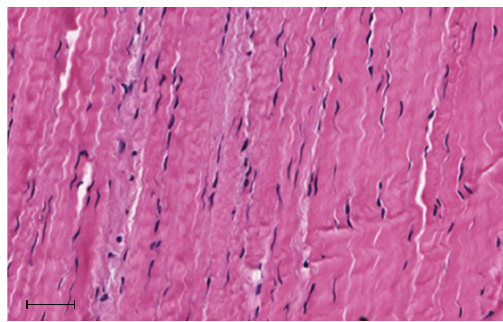
Figure 1: Normal Tendon. Note the relative paucity of